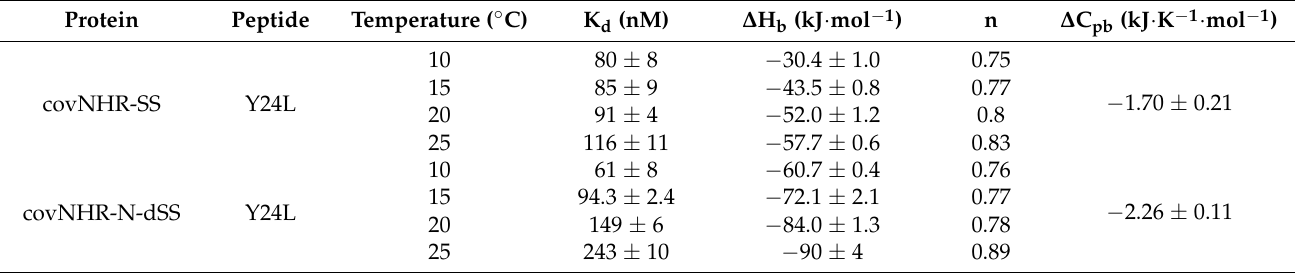
Table 1. Thermodynamic parameters of binding of gp41 CHR peptide Y24L to covNHR miniproteins measured by